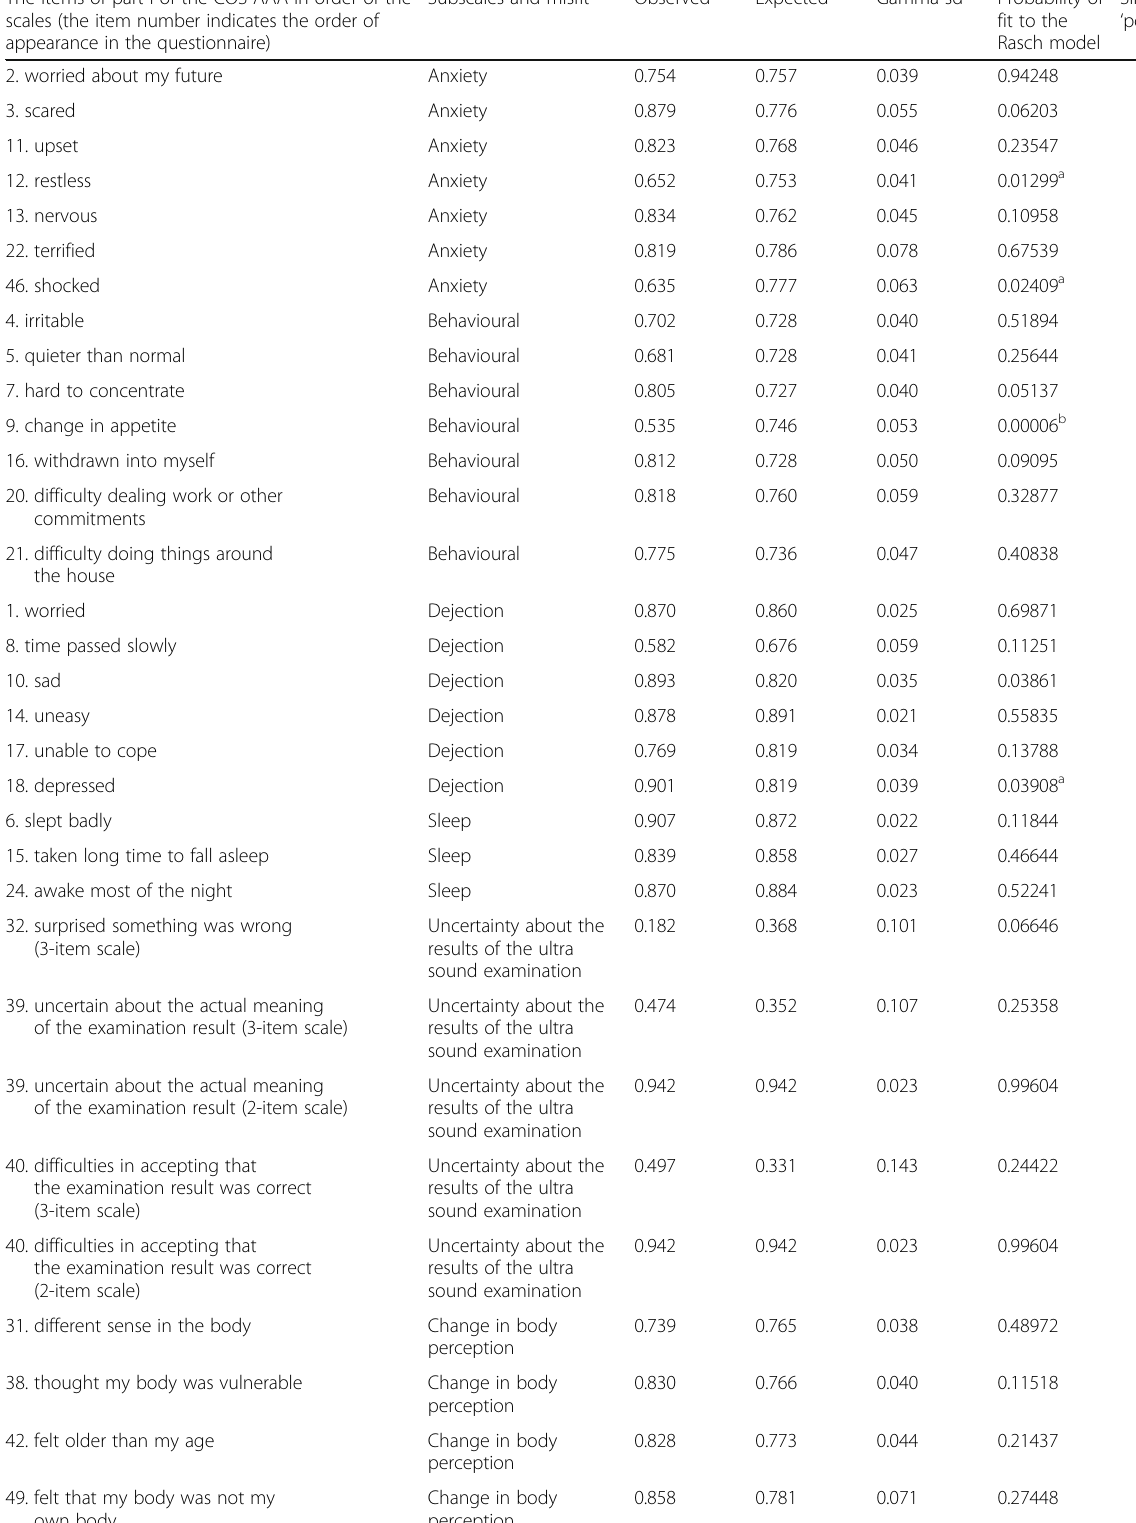
Table 3 Summary of result from the psychometric analyses of part 1 of the COS-AAA The items of part I of the COS-AAA in order of the scales (the item number indicates the order of appearance in the